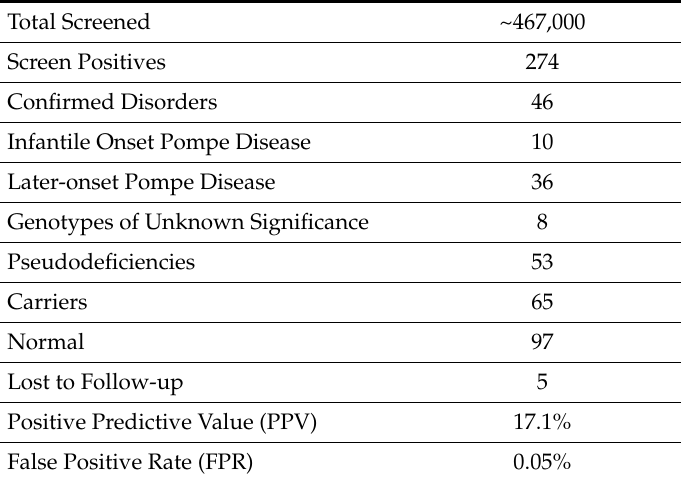
Table 2. Results of Confirmatory Pompe Testing.